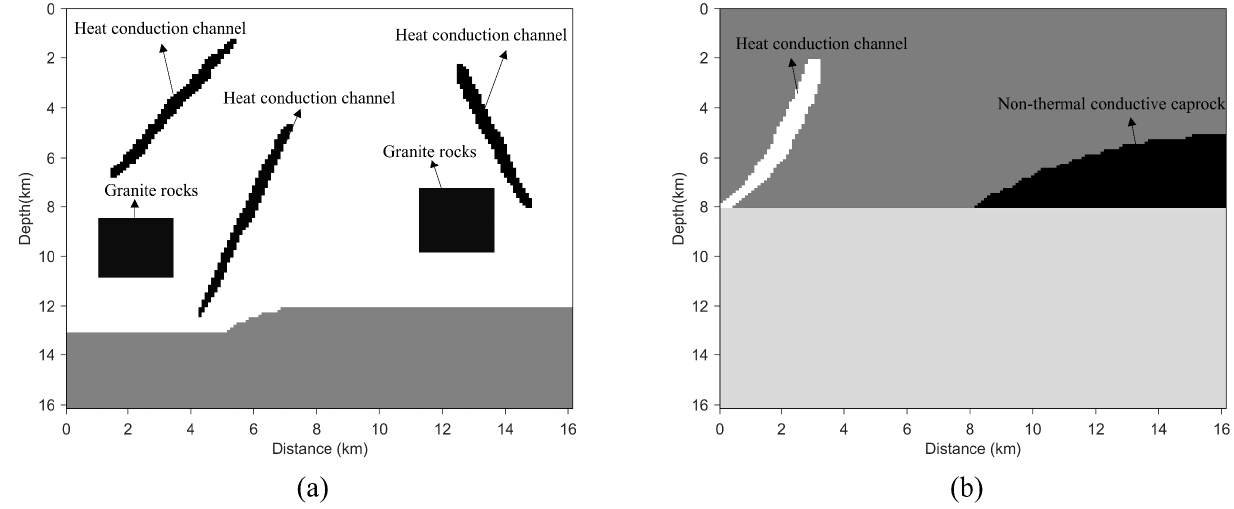
Figure 9. Two–dimensional (2D) geological model. ( a ) The first model consist of the heat conduction channels and granite with high thermal conductivity; ( b ) The second model contains fractures and caprock.